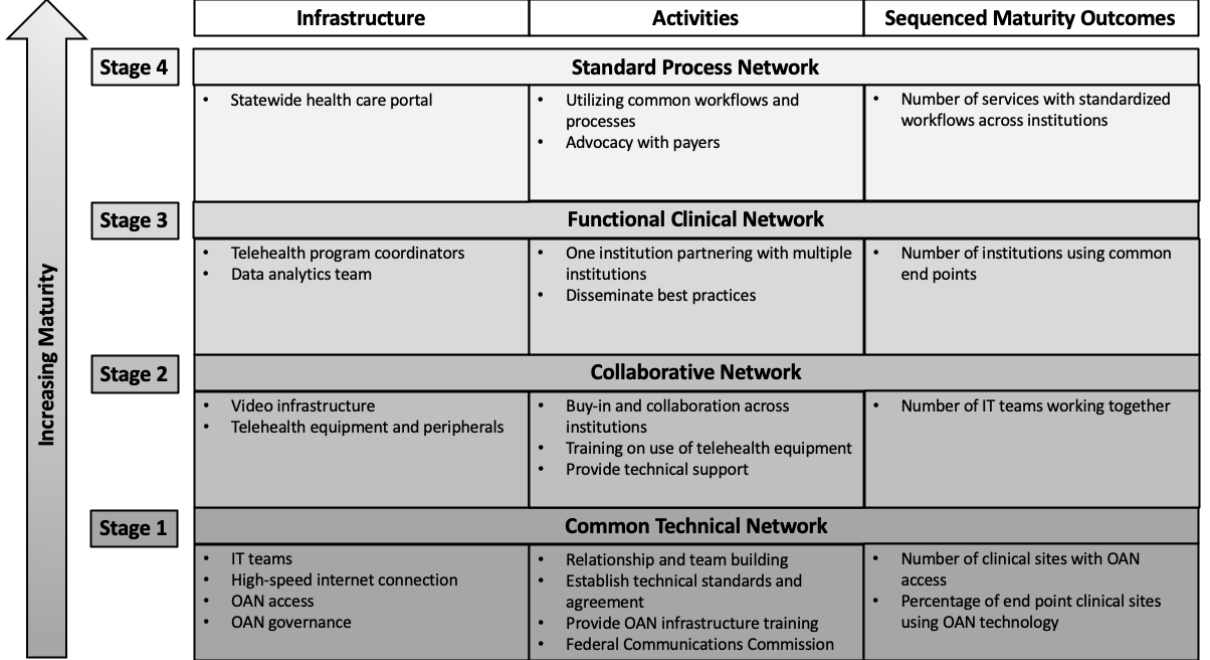
Figure 1. Proposed model for maturing a telehealth open access network. FCC: Federal Communications Commission; IT: information technology; OAN: open access